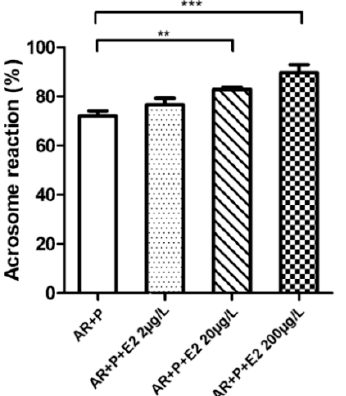
Figure 6. Acrosome reaction during 90 min capacitation (C) in simultaneous presence of estradiol (E2) and progesterone (P). Sperm were capacitated in capacitating medium in presence of progesterone (10 µ M, 3144 µ g/L) with E2 (C + P + E2: 2, 20, and 200 µ g/L) or without E2 (control, C + P). A total of 200 cells were counted in six individual samples. No differences were detected in contrast with control samples. The AR rate was the same for all different experimental E2 concentrations. Error bars indicate the SD. There was no statistical significance among sperm incubations with different E2 concentrations.